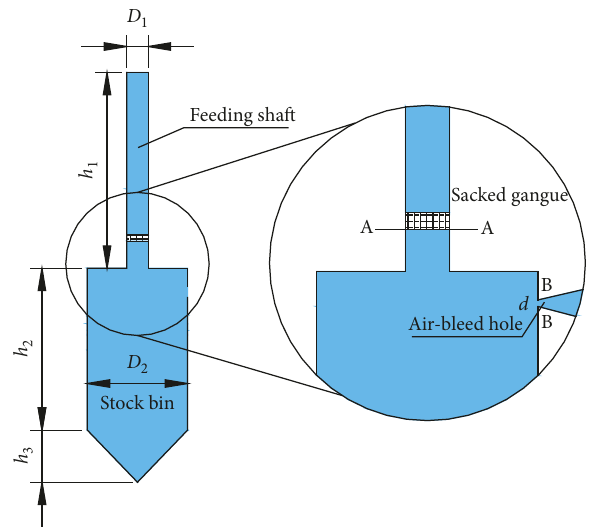
Figure 7: Model with an exhaust